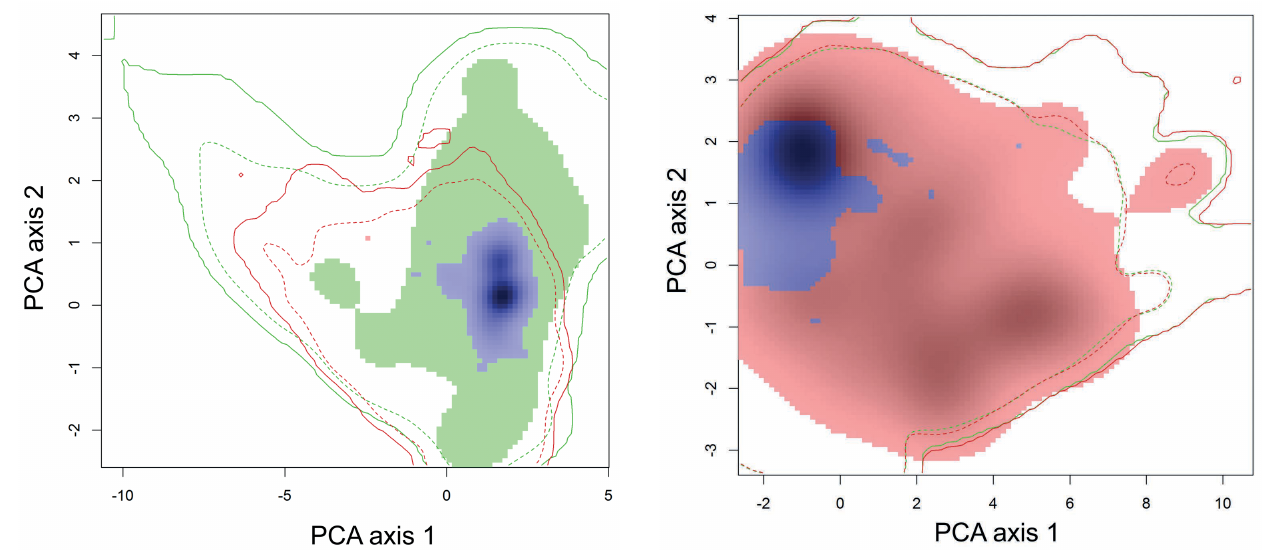
Figure 1 – Principal component analysis (PCA) comparing the climatic niches of the Peruvian peppertree between the native and invaded region. Contour lines indicate 100% (solid lines) and 75% (dashed lines) of the climatic environment that is available in the native region (green lines) and the invaded region (red lines). Coloured areas are the stable zone (blue area), the unfilled zone (green area) and expansion zone (red area) proposed by Petitpierre et al. (2012).